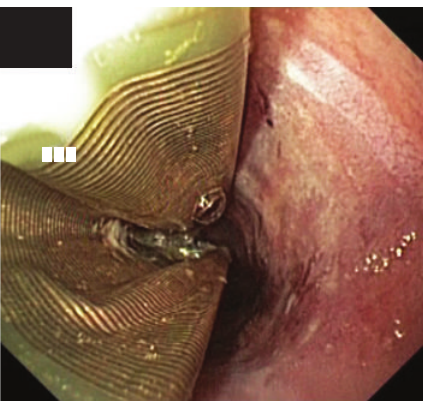
Figure 1: RFA catheter deflated inside the esophagus after the first ablating session. On the right is clearly visible the greyish ablated mucosa.